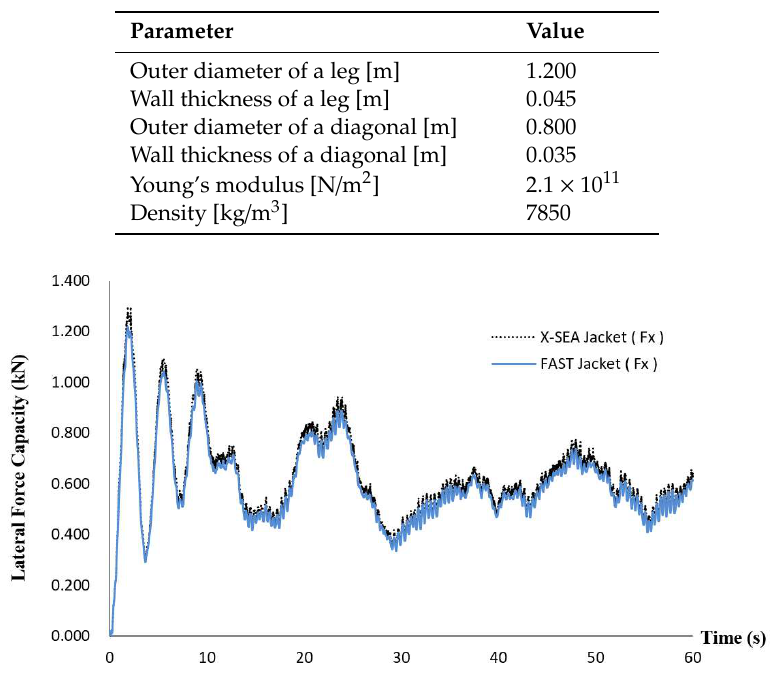
Figure 5. Comparison of the dynamic lateral reaction force capacity on the jacket support structure in the x-direction resulted from X-SEA and FAST v8 programs.